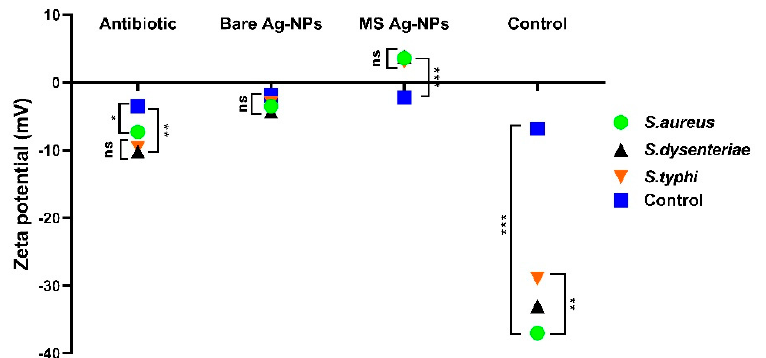
Figure 9. Zeta potential value of S. aureus , S. dysenteriae , and S. typhi to compare membrane surface damage caused by MS-AgNPs, Bare AgNPs, antibiotics, and control (untreated bacterial cells). Control in each treatment without bacterial cells. Control (only distilled water), control (Only MS Ag- NPs), control (only bare Ag-NPs) and control (only antibiotic). Note: *** shows significant difference at p < 0.05, ** shows significant difference at p < 0.01, and * shows significant difference at p < 0.005.